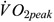
Correlations between A peak oxygen uptake (V˙O2peak; y = 0.81x + 0.51, r = 0.81, p≤0.001), C peak heart rate (HRpeak; y = 0.96x + 6.23; r = 0.95, p≤0.001) and E peak power output (PPO; y = 0.84x - 4.55; r = 0.89, p≤0.001), and Bland-Altman plots of the absolute differences between BV˙O2peak, D HRpeak and F PPO determined during maximal incremental test with short (STest) and long (LTest) time duration.In A, C and E, the dotted line represents the line of identity. In B, D and F, the light dotted line represents the bias from the mean difference, and the dark dotted line represents the upper and lower 95% limits of agreement.